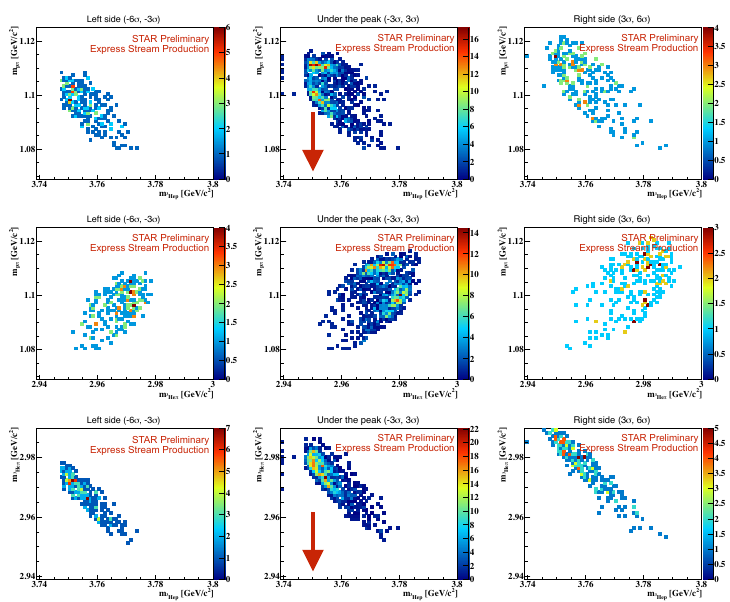
Figure 4. The Dalitz plots for the decay 4 Λ He → 3 He + p + π − which has the largest number of signals (978 decays) found using 2018, 2019, 2020, and 2021 data collected at di ff erent energies in the collider and fixed-target modes.